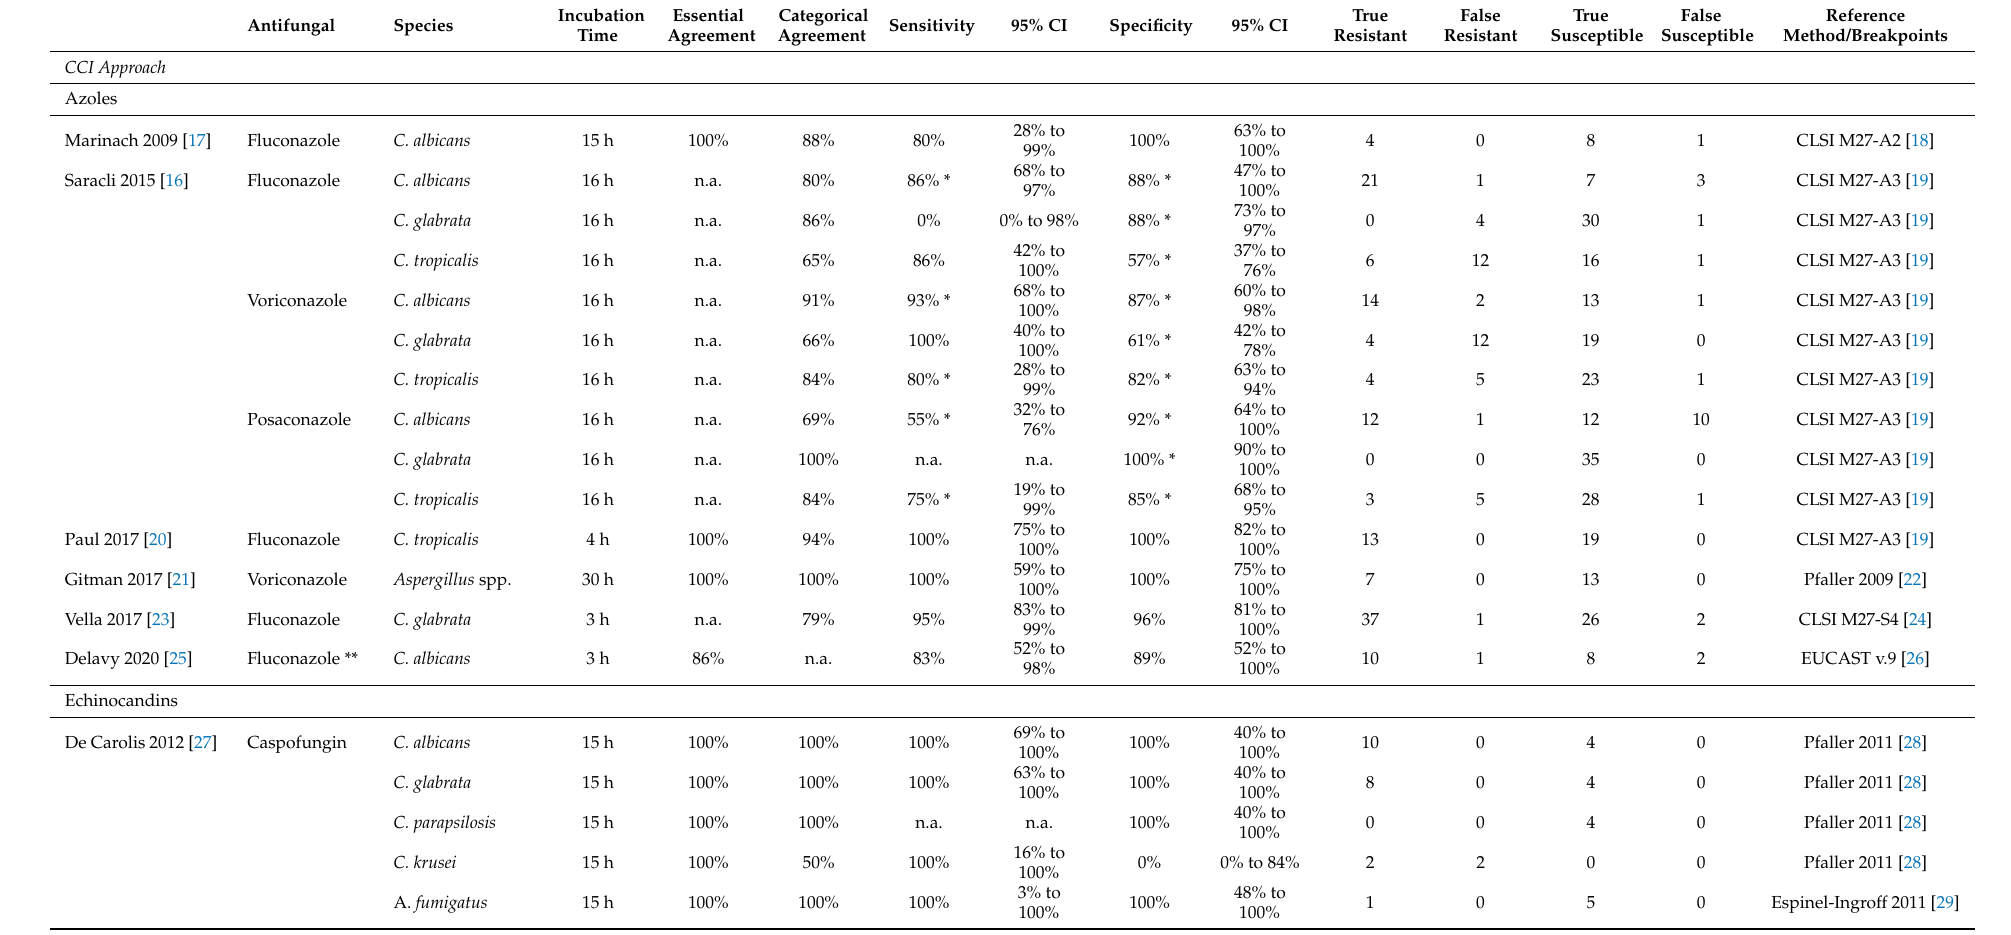
Table 1. Characteristics of the included studies ( n =